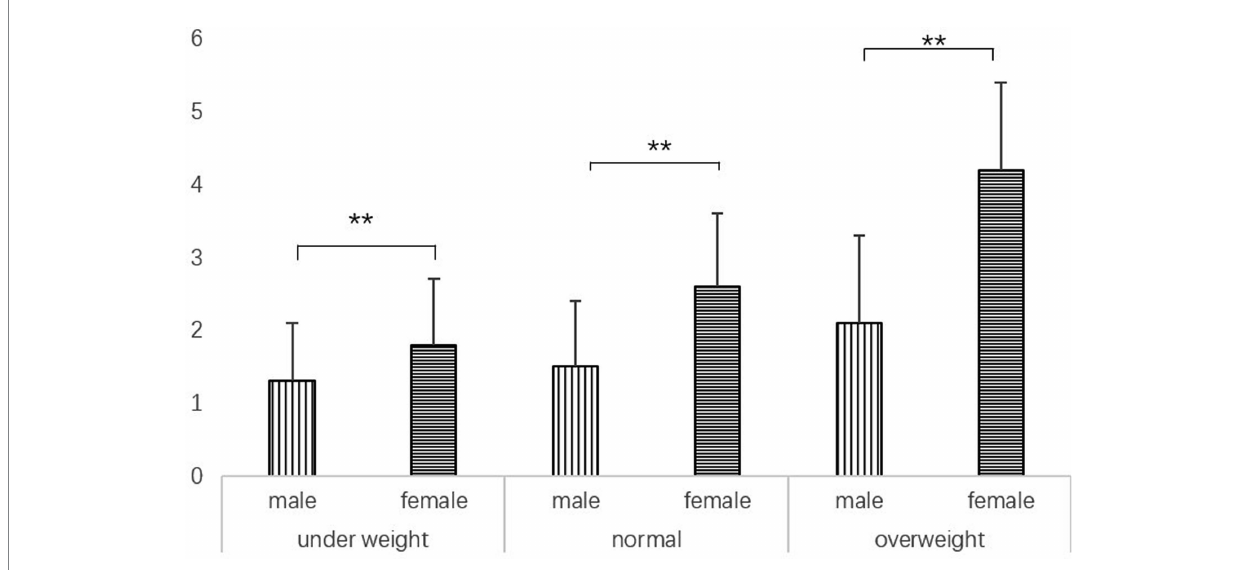
FIGURE 1 Sex difference of body satisfaction level in college students with different body shapes. ** t -test, p < 0.01.